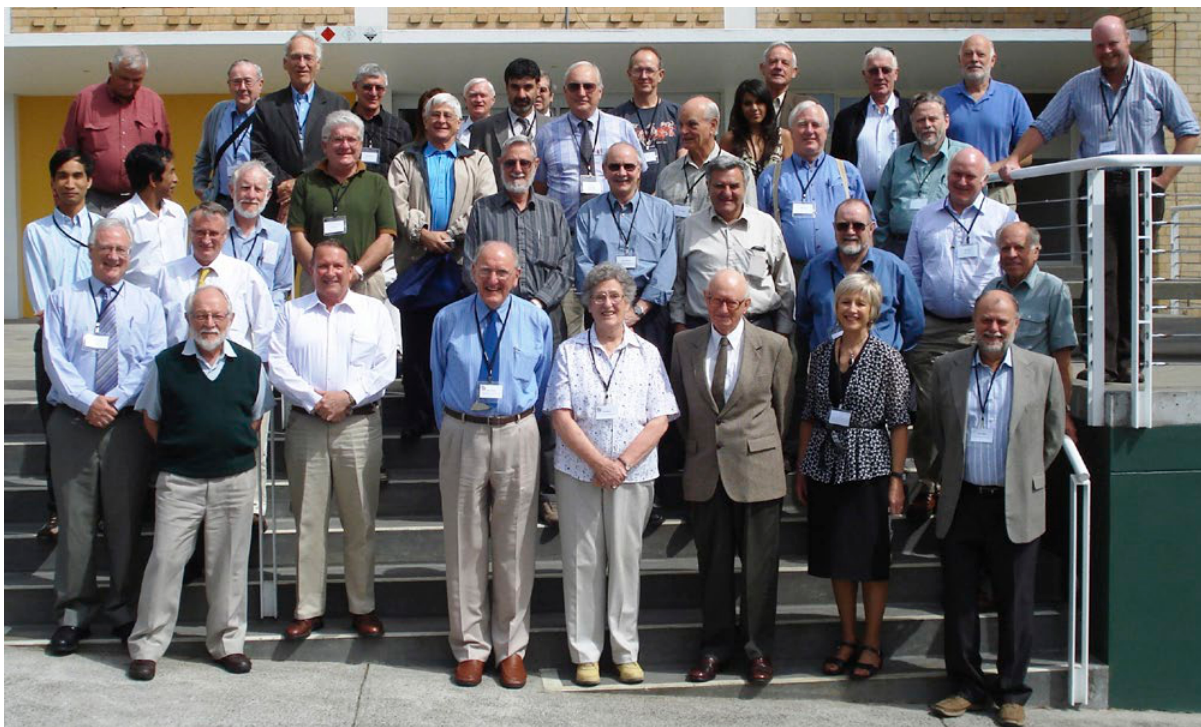
Figure 24. In this group of Australia’s top scientists at the CODES symposium in Hobart on 22nd to 23rd of November 2007 are: Jacob Rebek , Group Chief Geologist, Rio-Tinto Exploration – remobilisation of ore sulphides and sphalerite with hydrocarbons in the ore beds at Century zinc